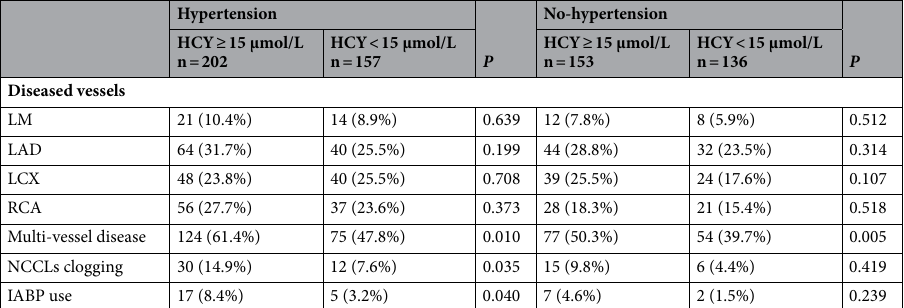
Table 2. Angiographic and procedural characteristics. LM, left main; LAD, left anterior descending coronary artery; LCX, Left circumflex artery; RAD, right coronary artery; NCCLs, non-culprit coronary lesions; IABP, intra-aortic balloon